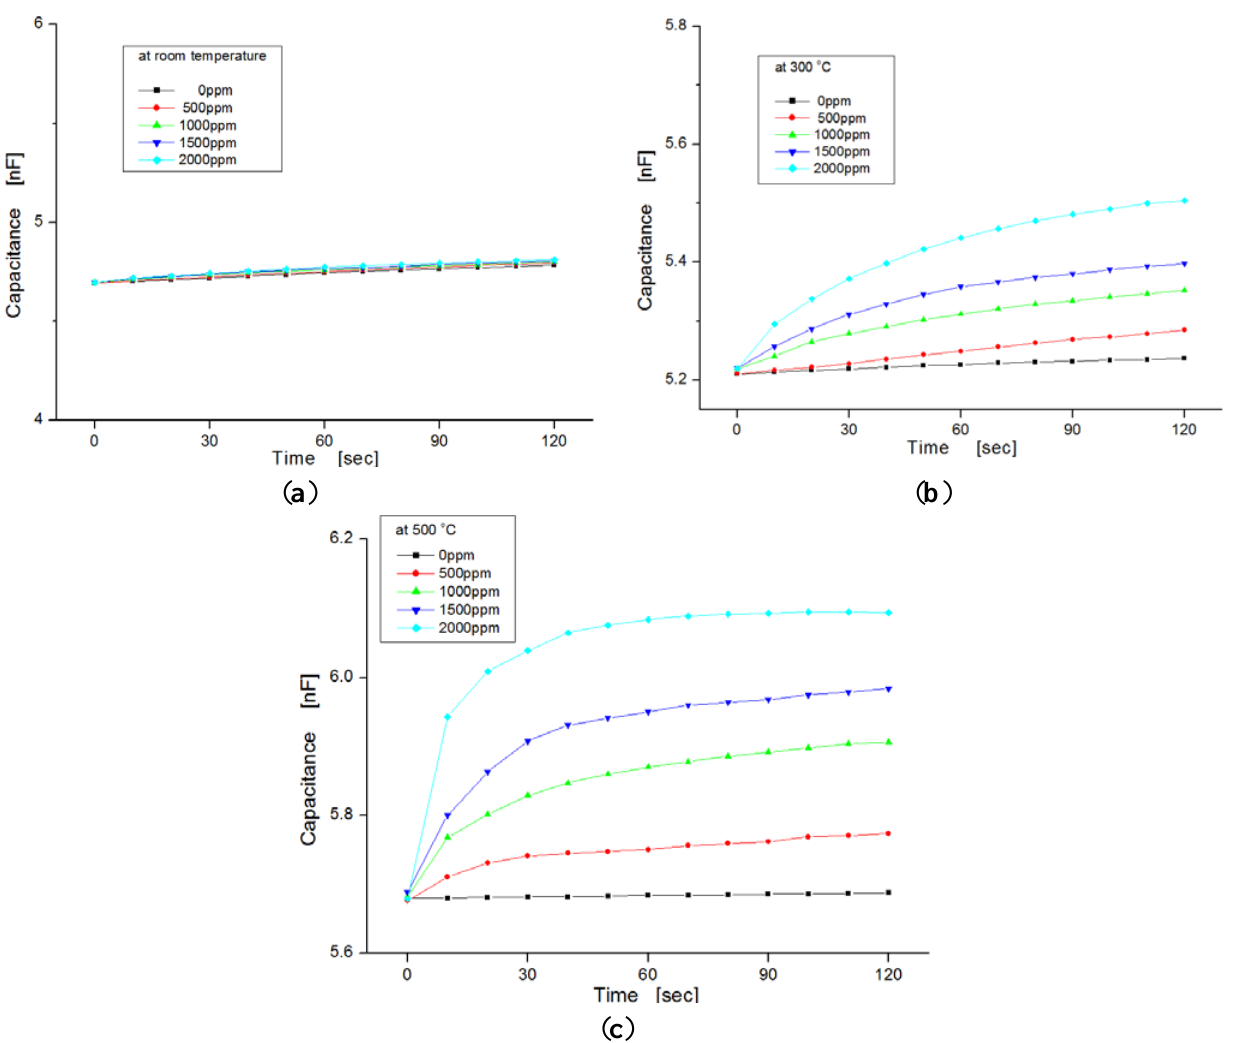
Figure 6. Dependence of capacitance on hydrogen concentrations as a function of temperature.